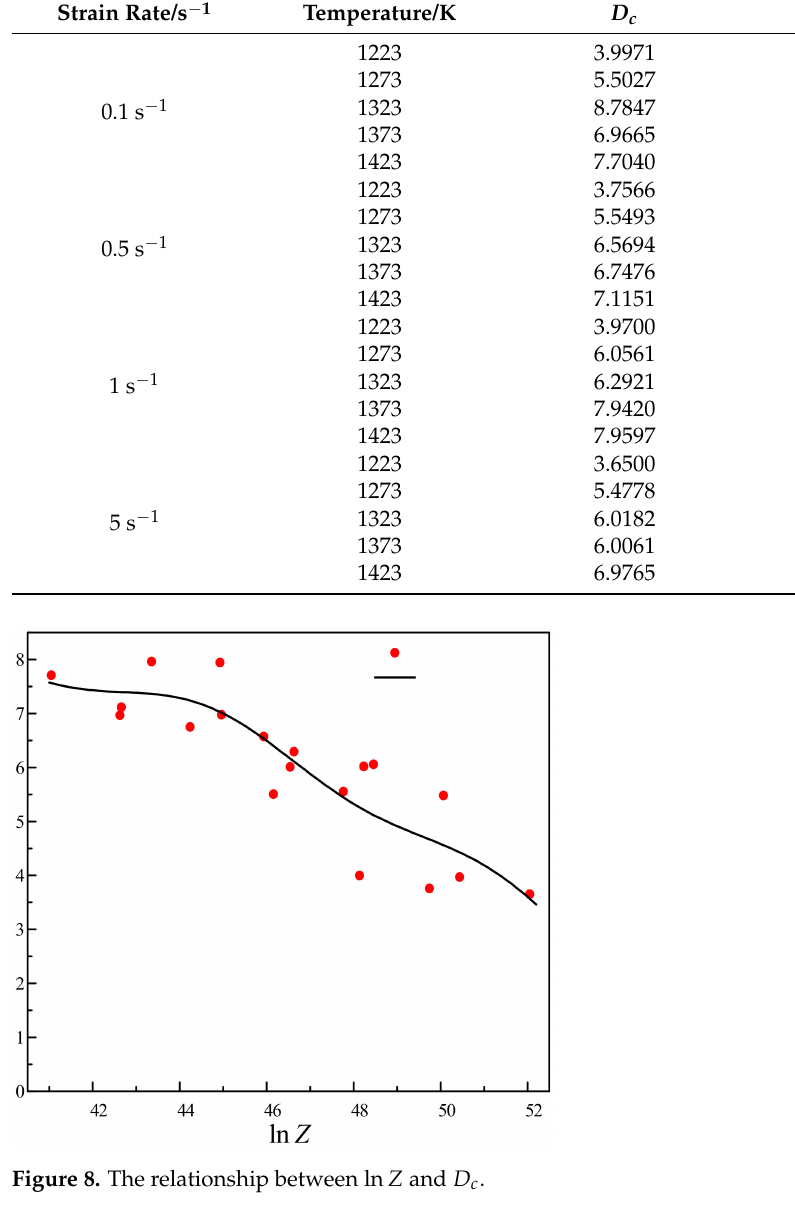
Table 3. Critical damage values D c of Oyane damage model at different temperatures and strain rates.